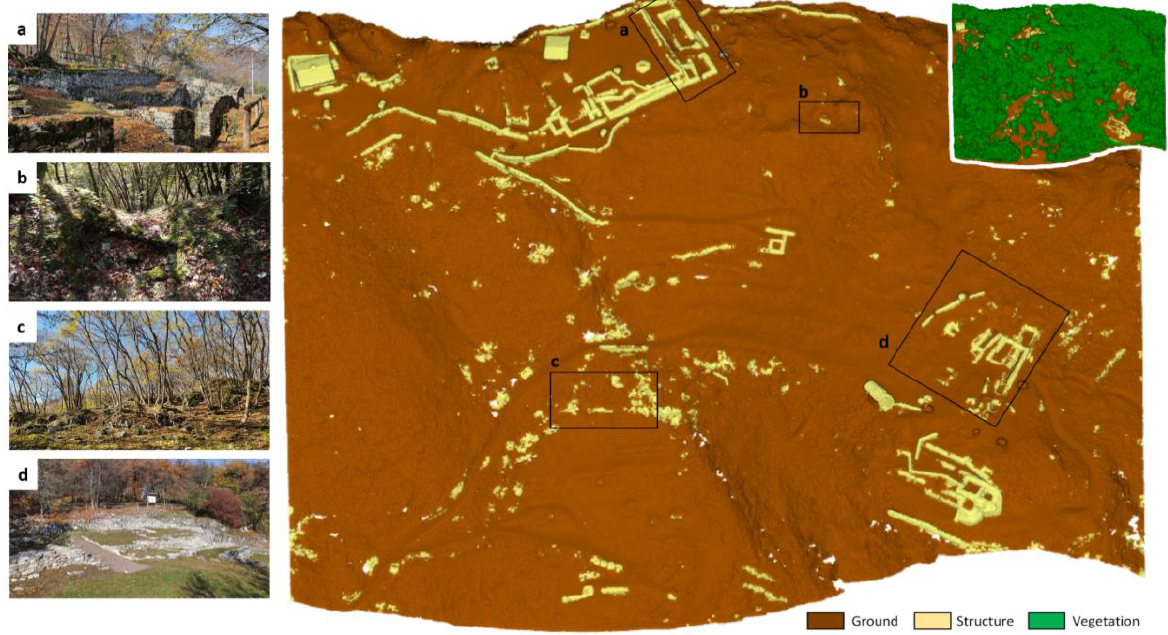
Figure 5. Final semantic segmentation results for Dataset_1 ( San Martino ai Campi archaeological